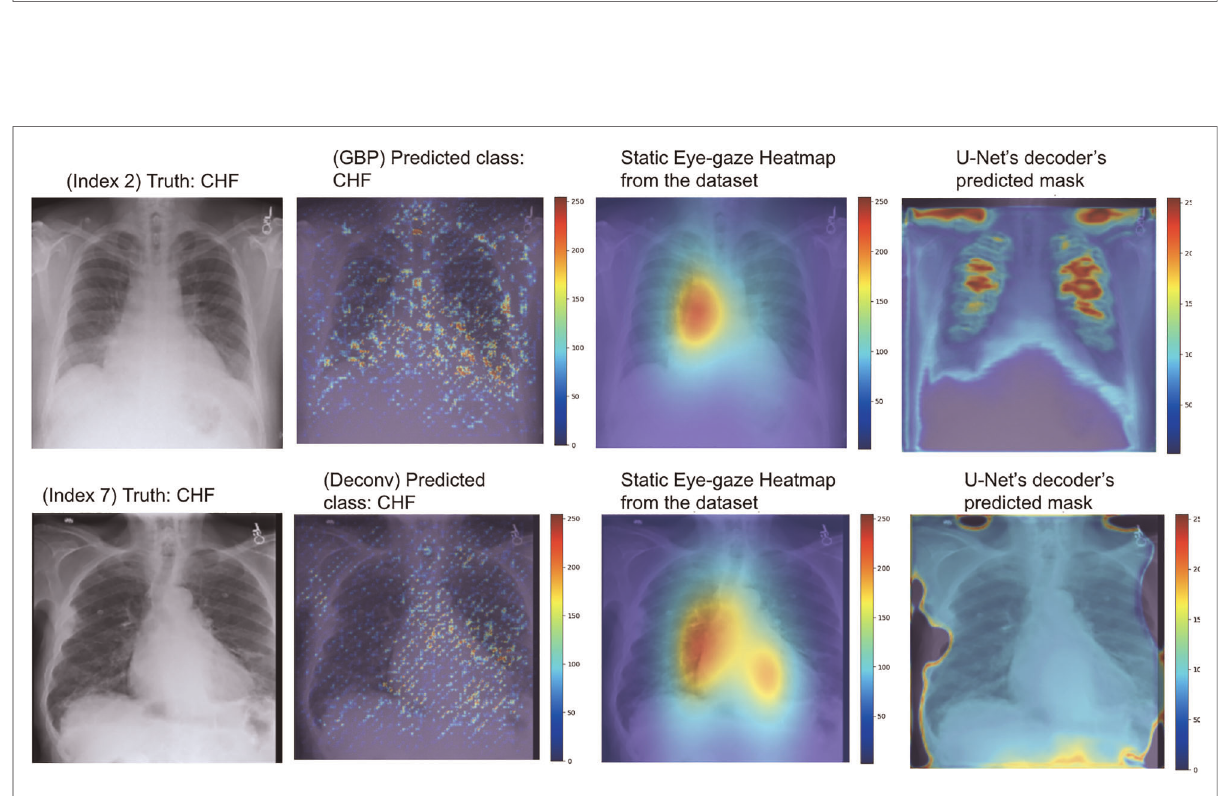
FIGURE 9 Model ’ s output heatmaps using GBP (top) and deconvNet (bottom) as the heatmap generator for Experiment Set 1 for the correctly classi fi ed CHF (top) and pneumonia (bottom) classes.